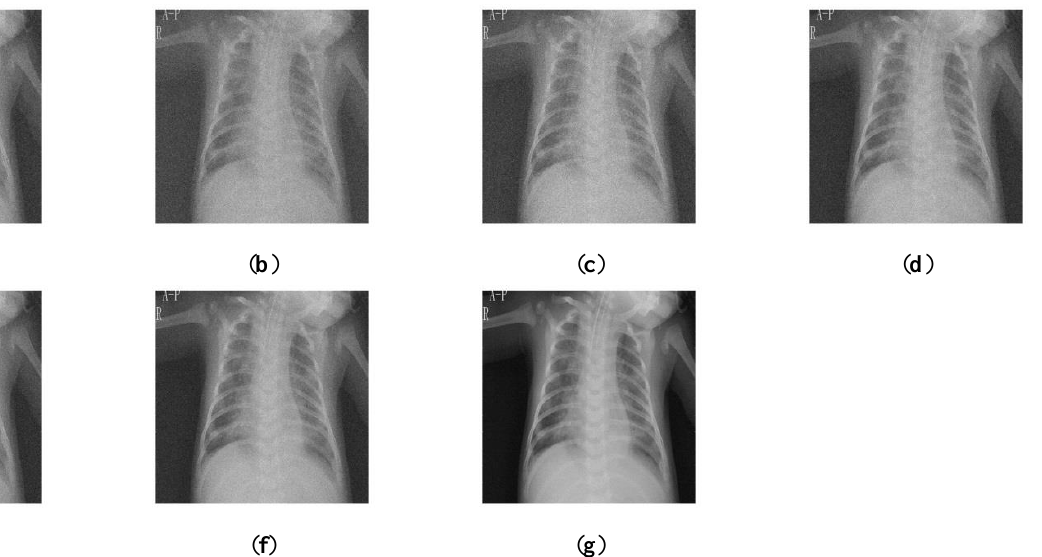
Figure 9. Results of CT image denoising, ( a ) Outcomes of Mingliang et al., 2016 [5]; ( b ) outcomes of